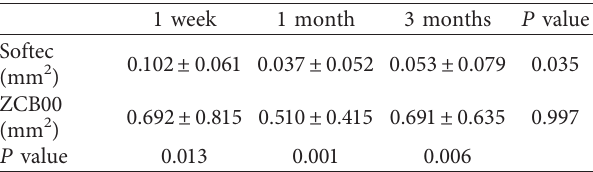
Table 4: Vertical IOL-PC space (mm 2 )